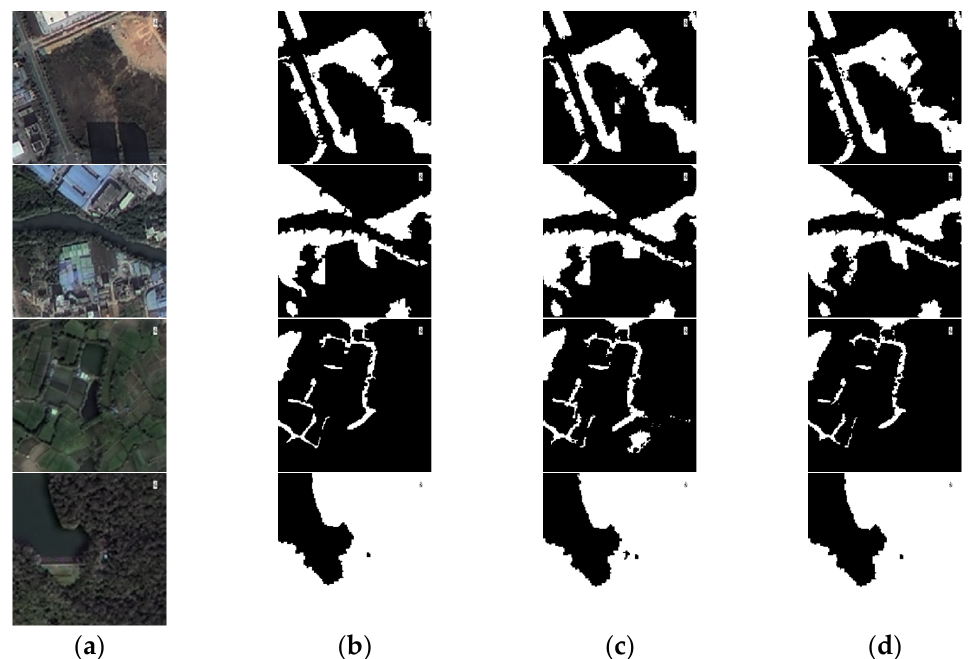
Figure 10. Results comparison between CRUNet and CRAUNet. ( a ) The original images; ( b ) Corresponding labels; ( c ) The predicted maps of CRUNet; ( d )The predicted maps of CRAUNet.